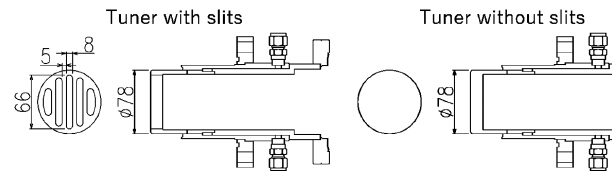
FIG. 11. Configuration of the end plate for the low-level